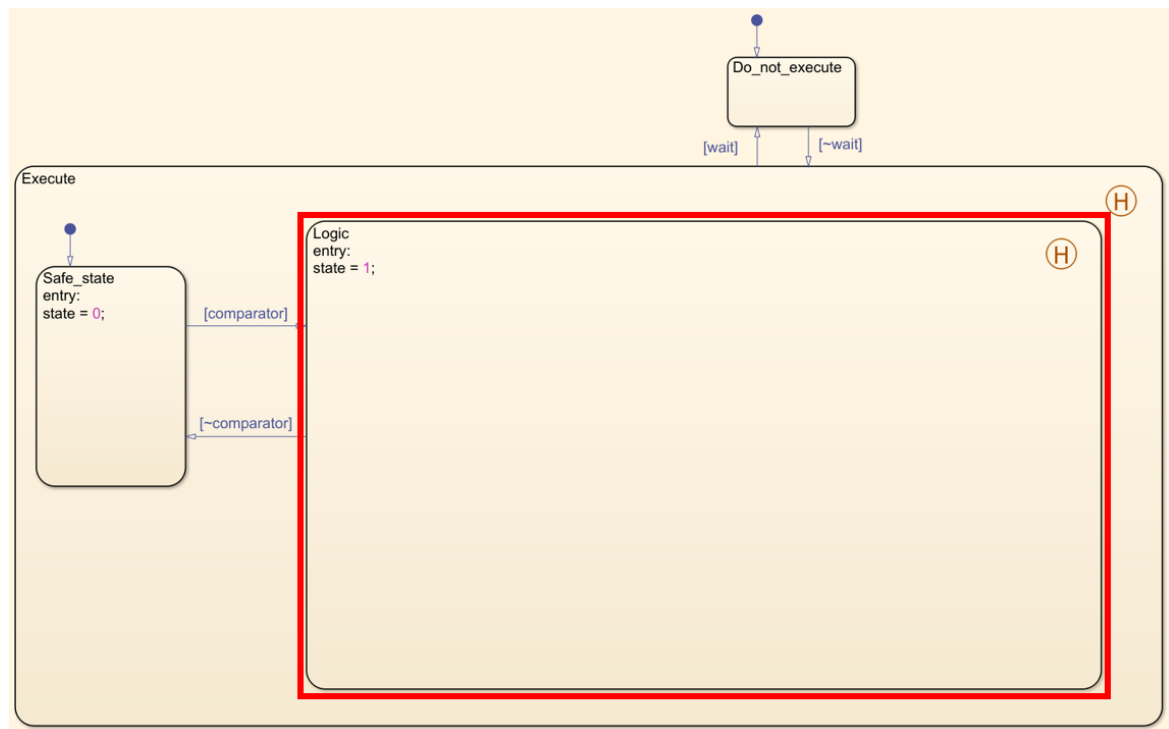
Figure 4. Template for the safety function (H means a marker for initial state after transition to back to state Execute .).